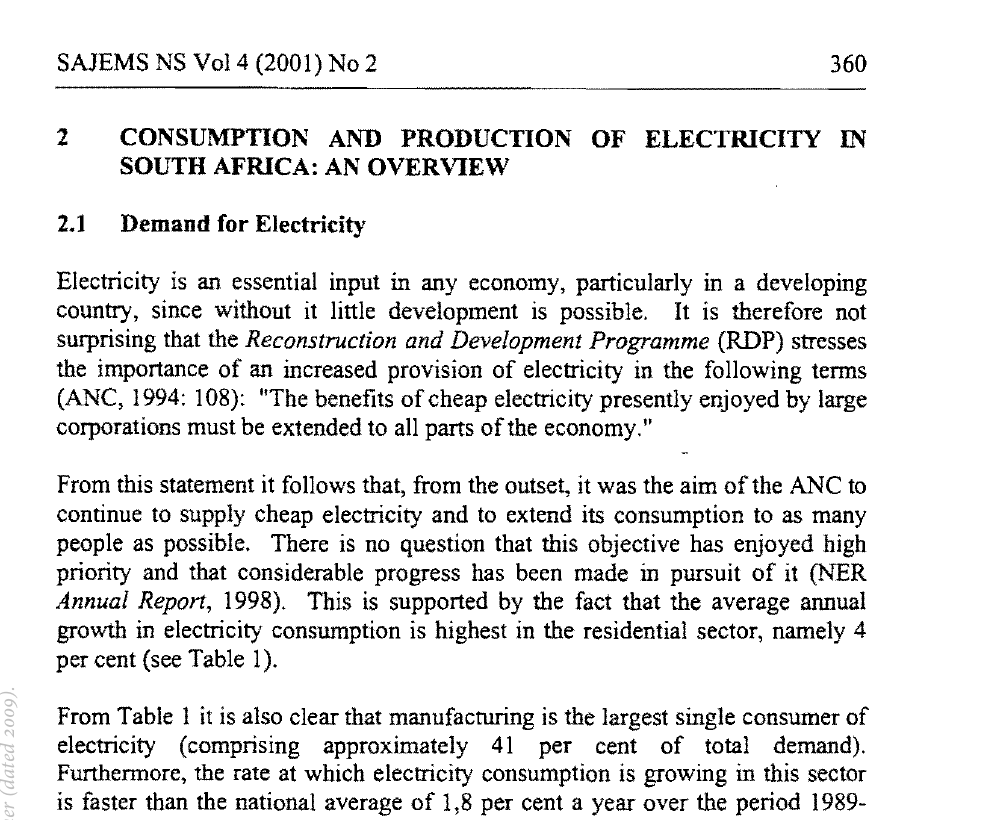
Electricity consumption in South Africa: 1989-1995